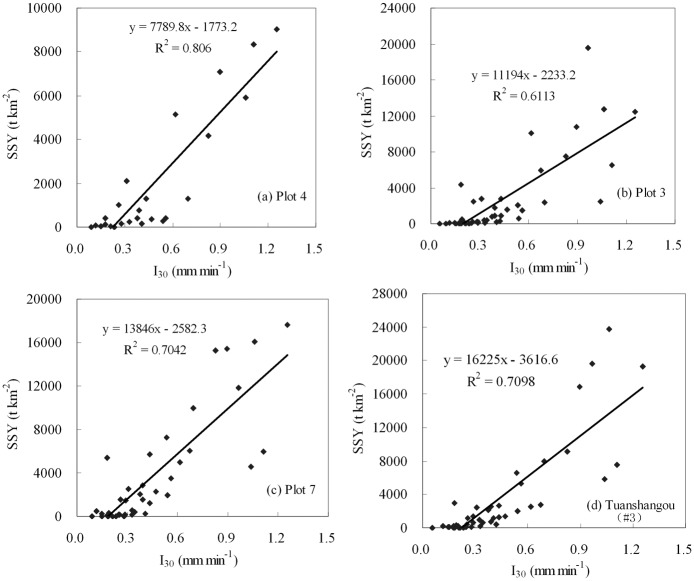
The relationship between I
30 and SSY for the Tuanshangou station (#3) and three experimental runoff plots within it.